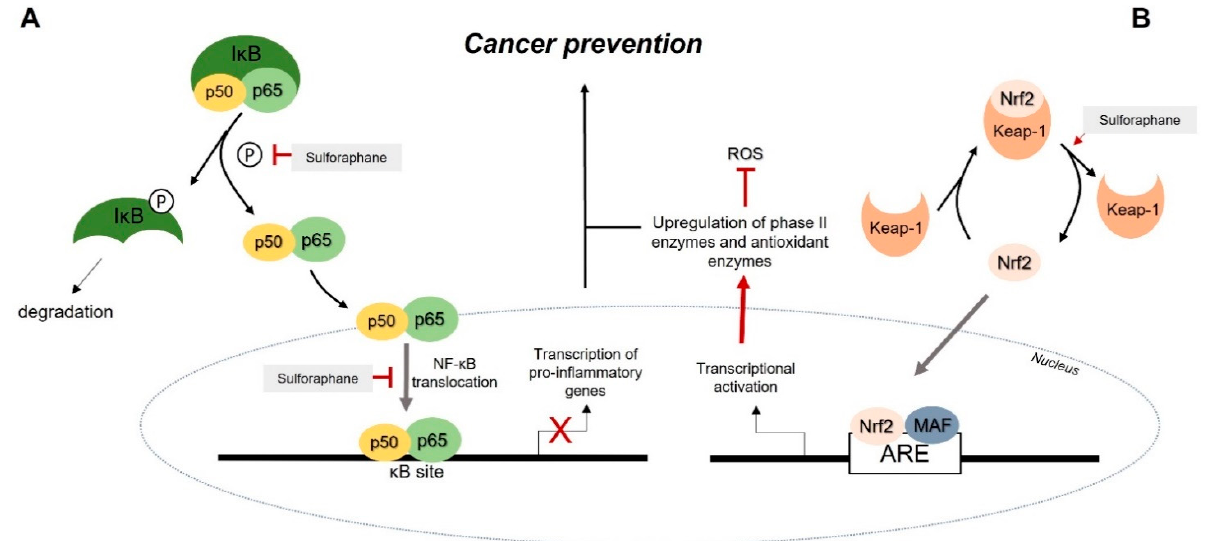
Figure 4. The cancer-preventive mechanism of sulforaphane through the NF-kB pathway ( A ) and the Nrf2 pathway ( B ). ( A )—Sulforaphane can inhibit the phosphorylation of IkB and consequently the nuclear translocation of the subunit p65 of NF- κ B, which affects the transcription of pro-inflammatory genes. ( B )—Sulforaphane alters the interaction between Nrf2 and Keap-1, releasing Nrf2 and inducing its nuclear translocation. Subsequently, this transcriptional factor upregulates the expression of phase II enzymes and antioxidant enzymes. ARE: antioxidant response element; I κ B: inhibitor of kappa B; Keap-1: Kelch-like ECH-associated protein 1; MAF: Nrf2 transcriptional cofactor; Nrf2: nuclear factor E2-related factor 2; ROS: reactive oxygen species. Adapted from